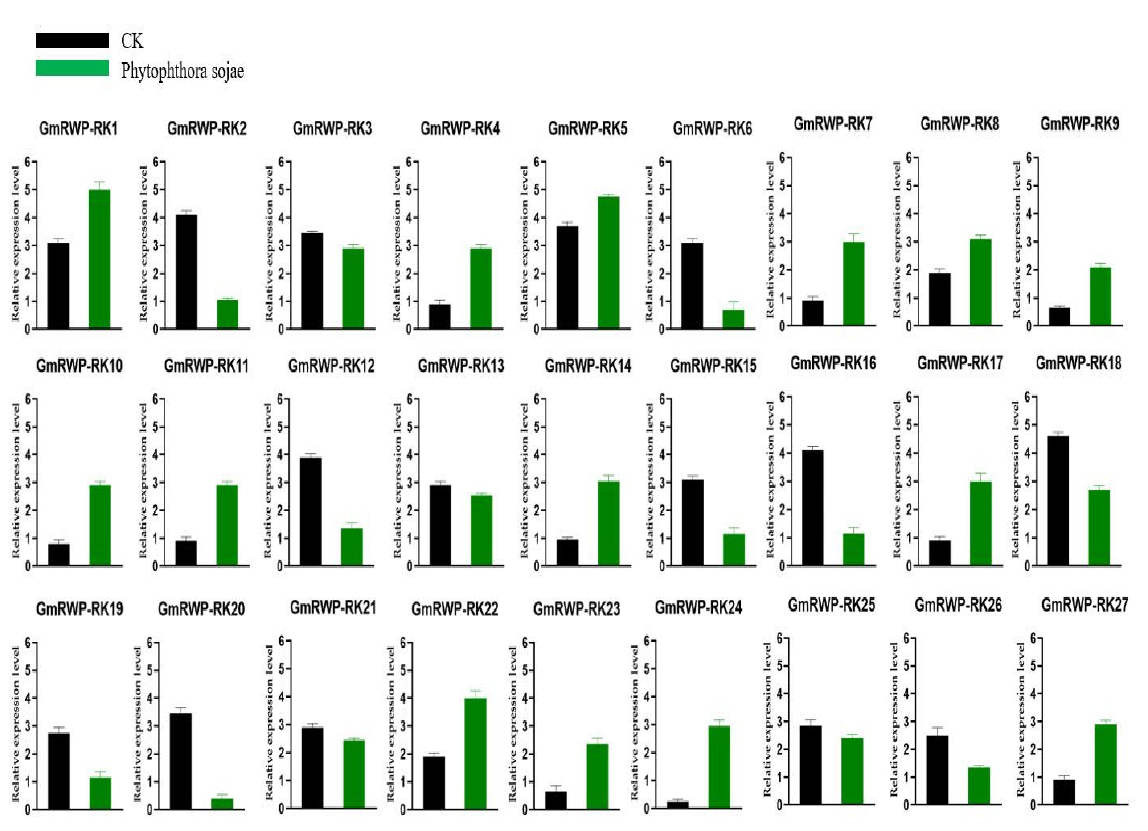
Figure 7. Relative expression level of GmRWP ‐ RK genes in the root tissues of soybean in re ‐ sponse to P. sojae infection using qRT ‐ PCR analysis. Error bars show the ±SE from three inde ‐ pendent biological replicates.